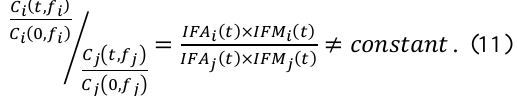
Fig. 2. Schematic diagram of the upgrade LO hopping relative